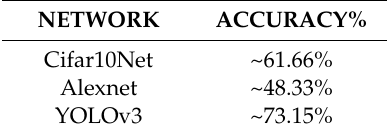
Table 7. Table with comparison of Cifar10Net, AlexNet and YOLOv3